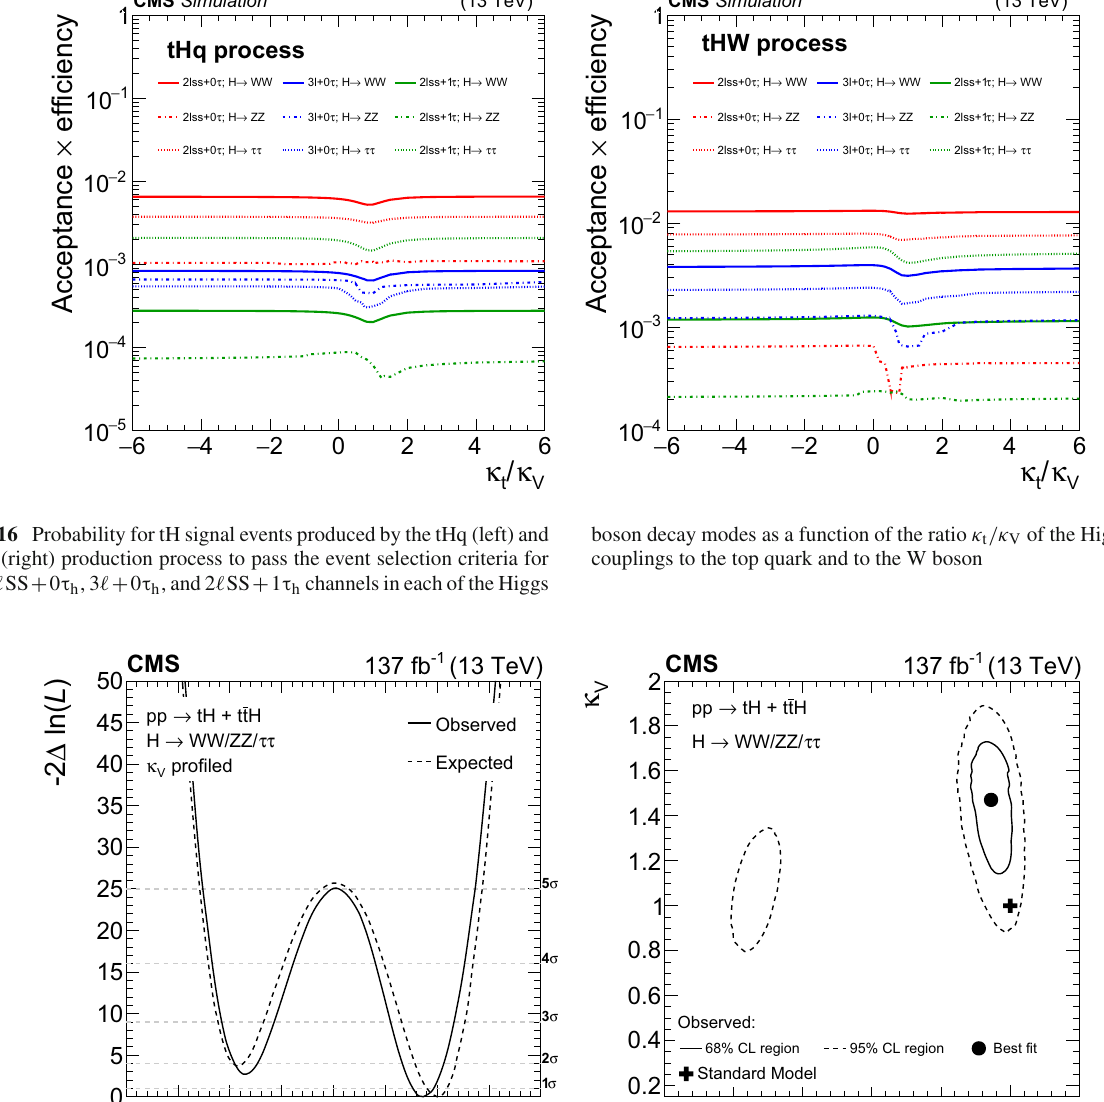
the Higgs boson decay modes H → WW and H → ZZ. We compute the compatibility of the data with different values of κ t and κ V , as is shown in Fig. 17. We obtain a 95% confi- dence level (CL) region on κ t consisting of the union of the two intervals − 0 . 9 < κ t < − 0 . 7 and 0 . 7 < κ t < 1 . 1 at 95% confidence level (CL). At 95% CL, both the inverted top coupling scenario and the SM expectation κ t = 1 are in agreement with the